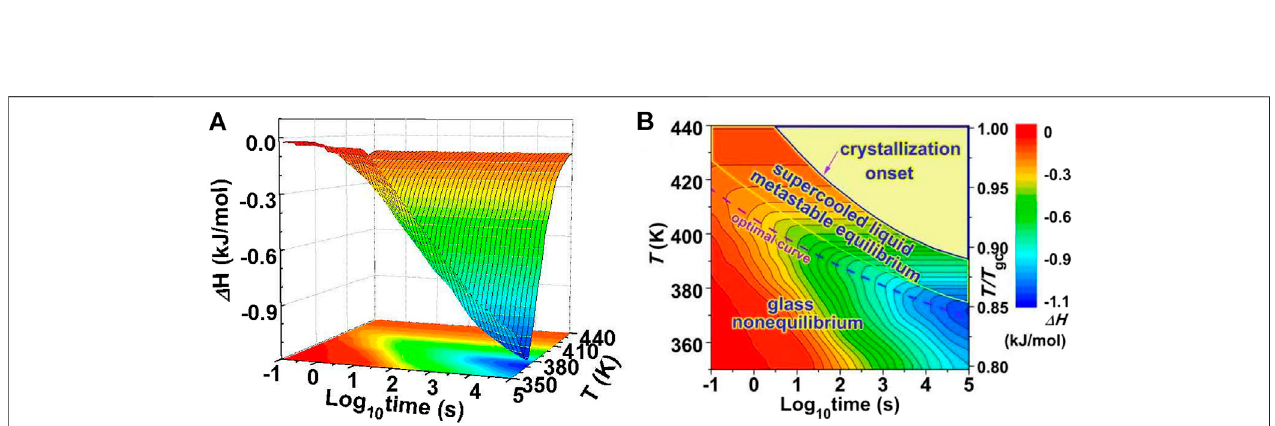
FIGURE 12 | (A) Three-dimensional plot and (B) Two-dimensional contours of enthalpy decrease ( Δ H ) for a Au 49 Cu 26.9 Ag 5.5 Pd 2.3 Si 16.3 glass vs. isothermal annealing time (logarithmic) and annealing temperatures. From Figure 12B , the enthalpy diagram is divided into two regions before the crystallization appears: the nonequilibrium glass state and the metastable equilibrium supercooled liquid state. The optimal annealing temperatures to achieve the lowest enthalpy are exhibited by the dashed curve (from (Wang et al., 2016)).